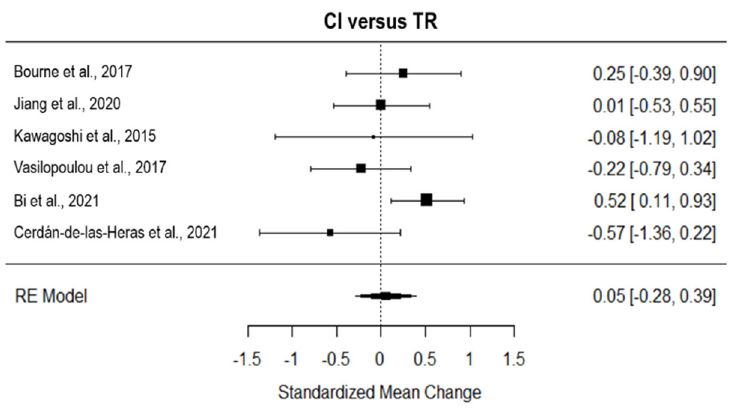
Figure 6. Forest plot of the effect of TR on quality of life compared to usual care. TR, TR; NI, no intervention [8,29,33–35,38,41]. [31] was not included in this analysis based on the leave-one-out analysis.